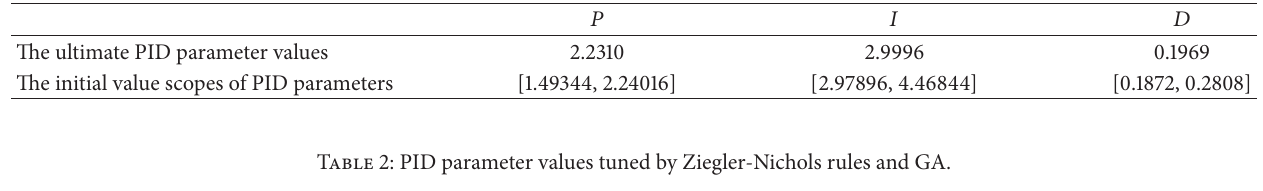
Table 1: The ultimate values and initial values scope of PID parameters in GA parameter optimization.